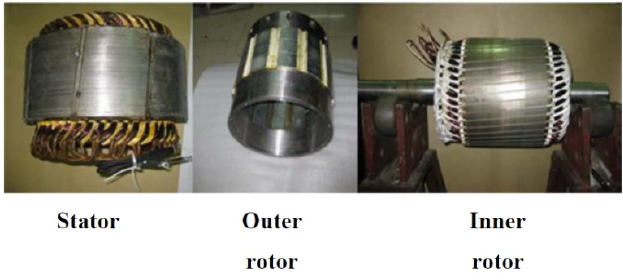
Figure 21. Prototype of the dual-rotor PM